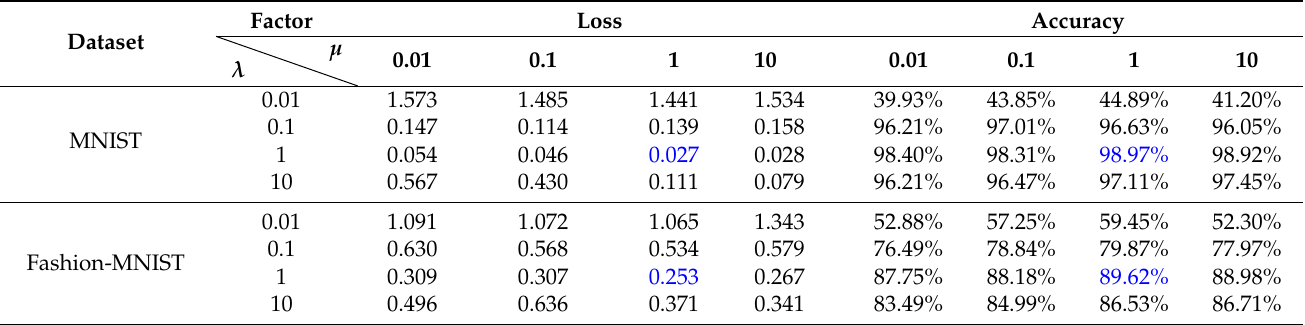
Table 1. Training loss and test accuracy on MNIST &